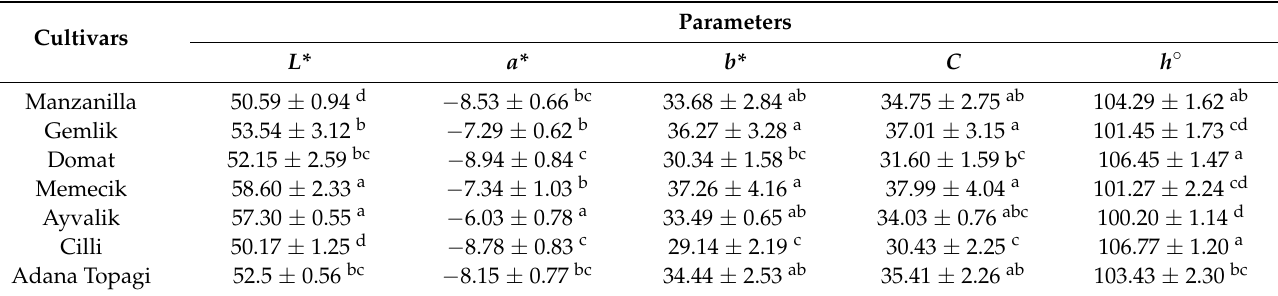
Table 1. The characterization of the skin color ( n =